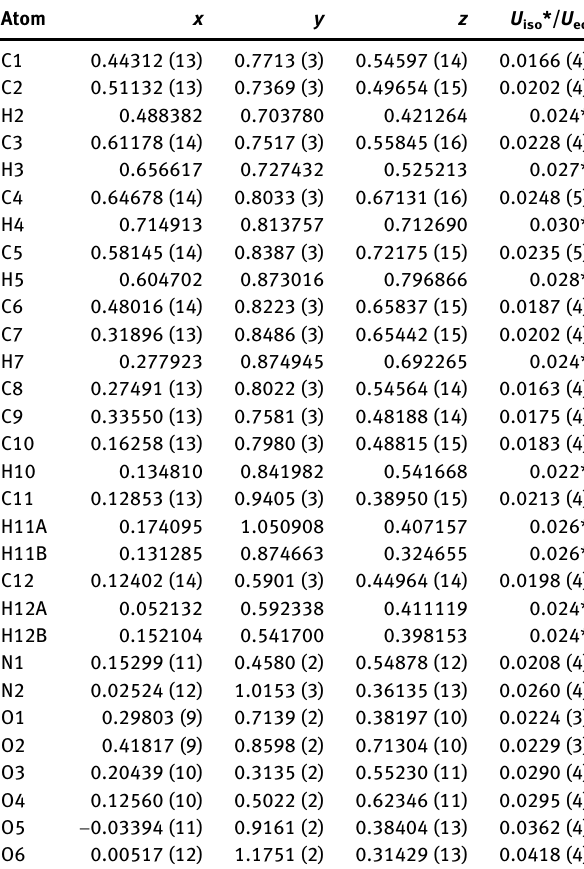
Table  : Fractional atomic coordinates and isotropic or equivalent isotropic displacement parameters (Å 